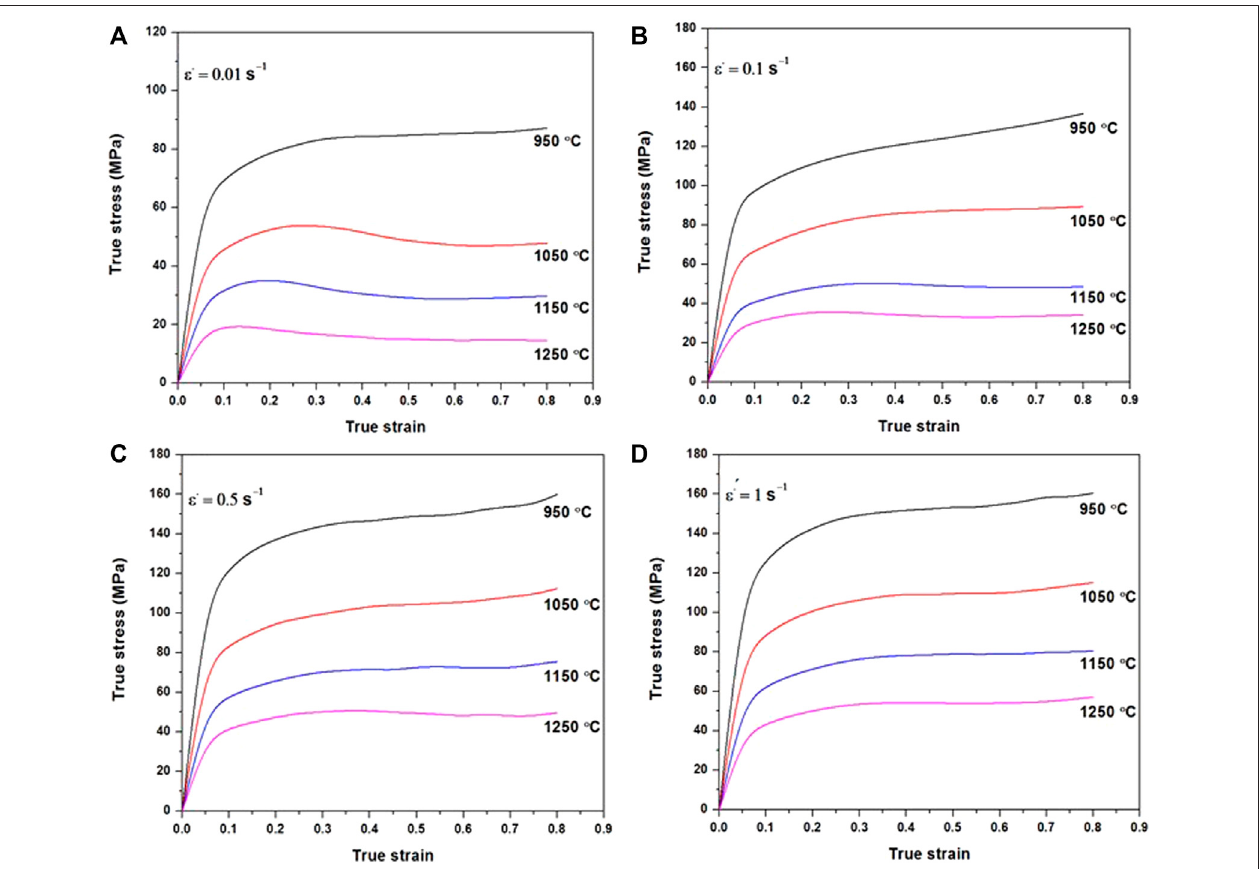
FIGURE 5 | Flow curves of 6140 under hot compression process. (A) Strain rate 0.01 s − 1 , (B) strain rate 0.01 s − 1 , (C) strain rate 0.01 s − 1 , and (D) strain rate 0.01 s − 1 .